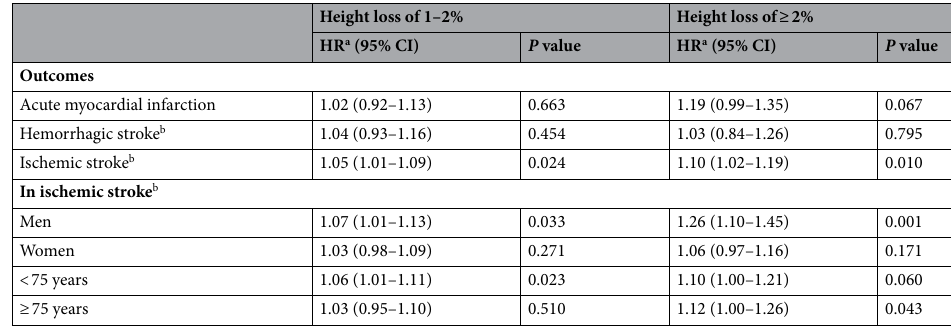
Table 3. Subgroup analysis for incident cardiovascular diseases by the degree of height loss (reference, group with height loss of < 1%). a From the multivariable Cox regression models with adjustment for age (continuous), sex, hypertension, osteoporosis, smoking status, coverage for low income, Charlson Comorbidity Index score (continuous), and body mass index (continuous). b Adjusted for CHA 2 DS 2 –VASc score instead of Charlson Comorbidity Index